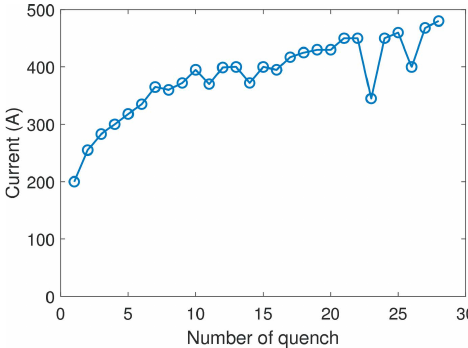
Figure 9 Graph of the SCU mock-up quench training.